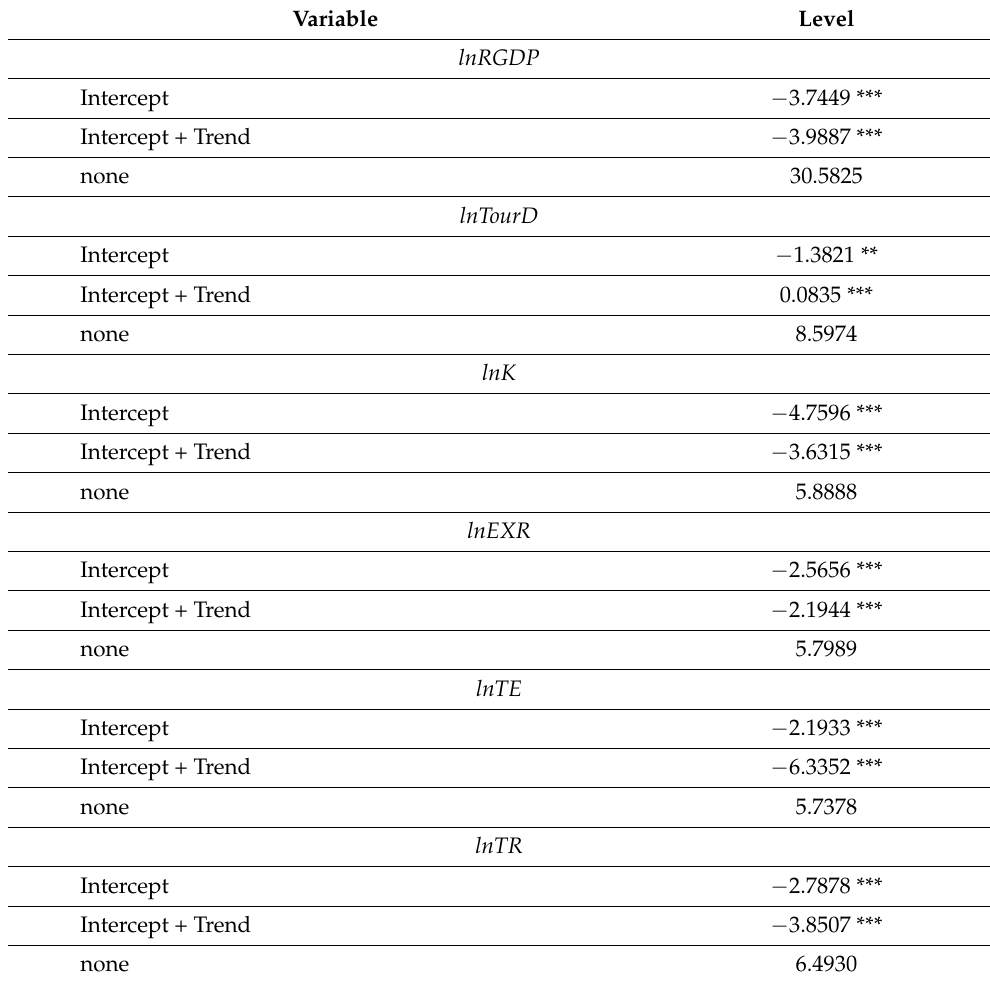
Table 2. Panel Unit Root